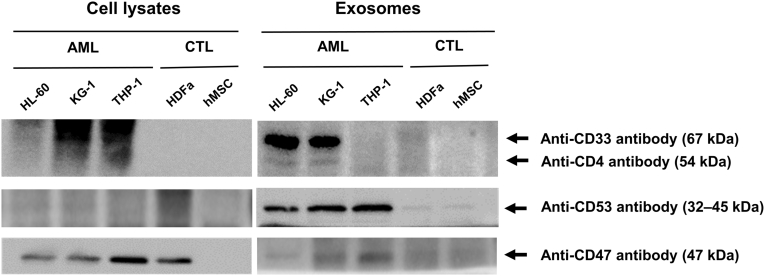
Validation of selected EV protein biomarkers. Among the top-ranked upregulated DEPs, surface antigens CD33, CD4, CD53, and CD47 were selected as AML protein biomarker candidates for further analysis. CD33, CD4, CD53, and CD47 were expressed in EVs from AML cell lines but not in EVs from control cell lines. CD53 and CD47, upregulated in all three AML cell lines, were selected as the final candidates for the use as biomarkers. AML, acute myeloid leukemia; EVs, extracellular vesicles; DEPs, differentially expressed proteins.